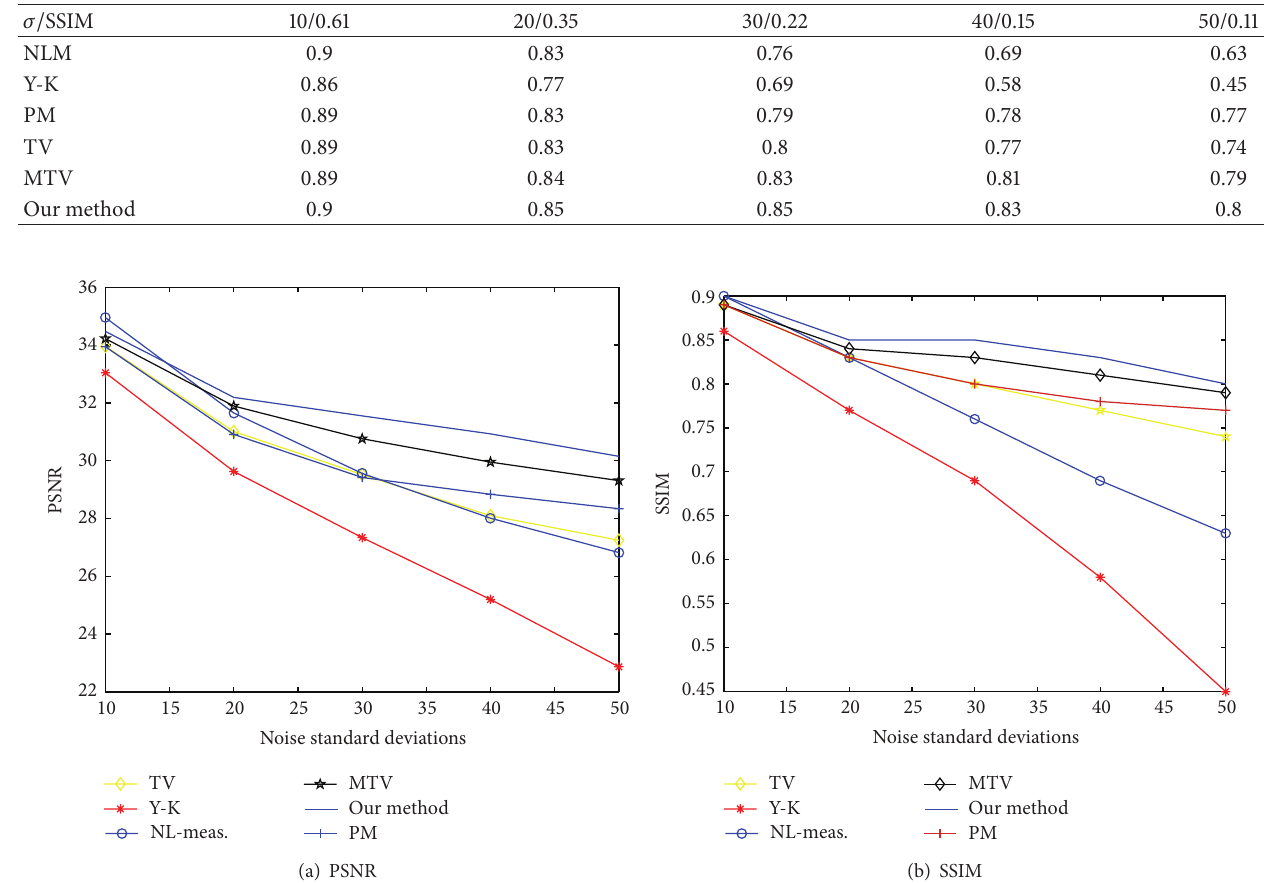
Table 5: SSIM comparison with different methods for the “lena” image.